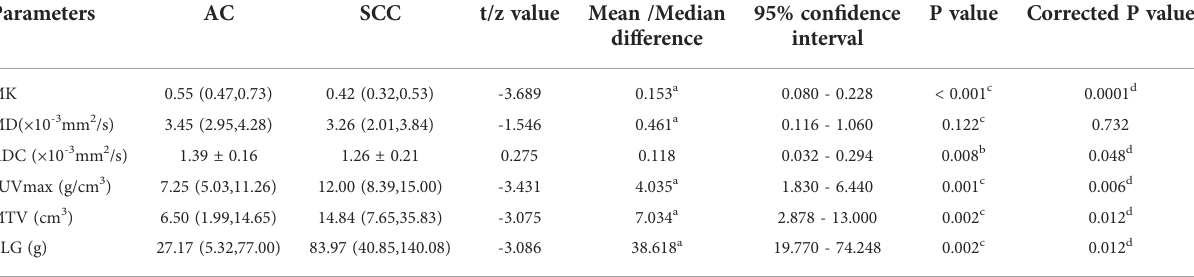
TABLE 3 Comparison of different parameters in subtypes of